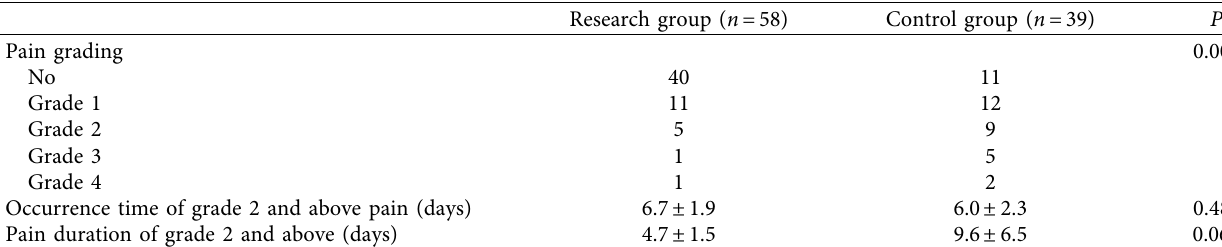
Table 4: Pain conditions.